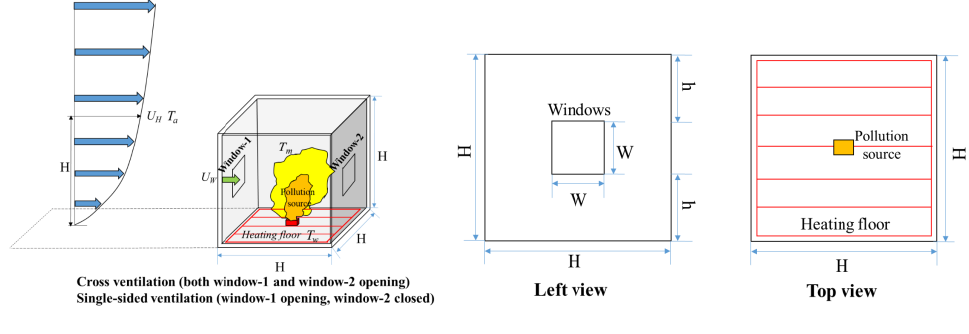
Figure 1. Physical model.